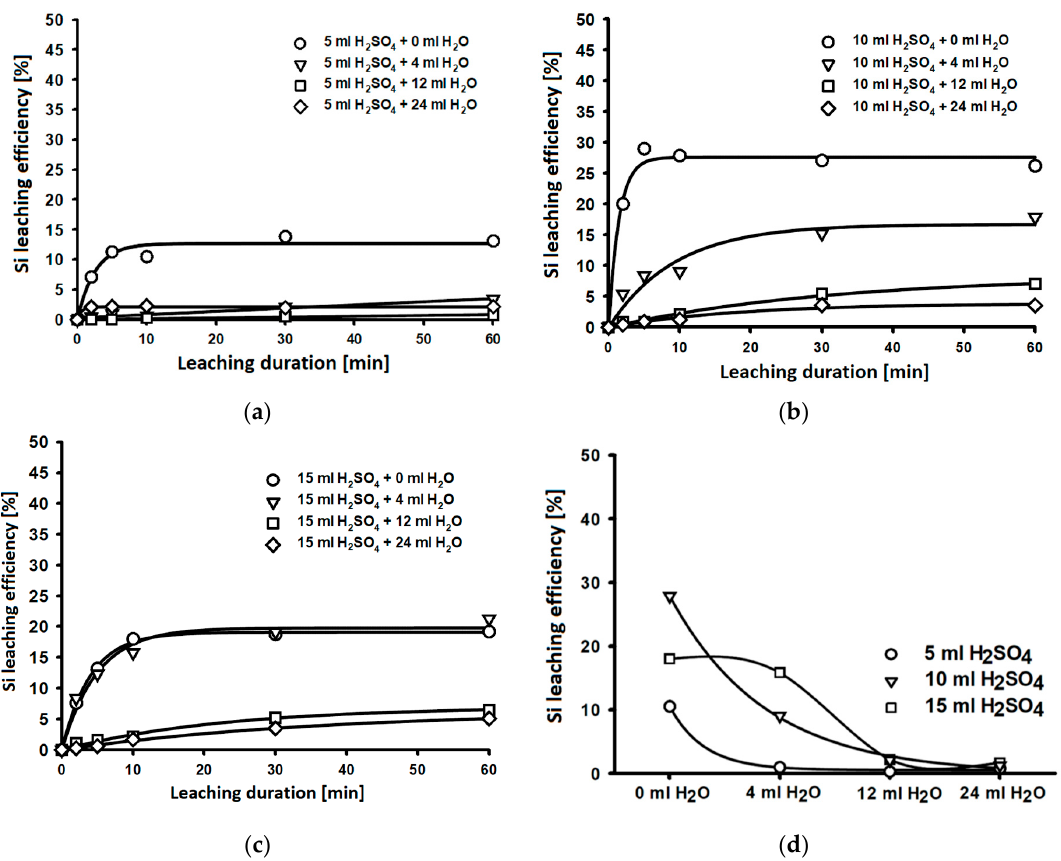
Figure 18. Silicon leaching efficiency in H 2 O using ( a ) 5 mL of H 2 SO 4 , ( b ) 10 mL of H 2 SO 4 , ( c ) 15 mL of H 2 SO 4 , ( d ) silicon dissolution in 10th min of neutral leaching.